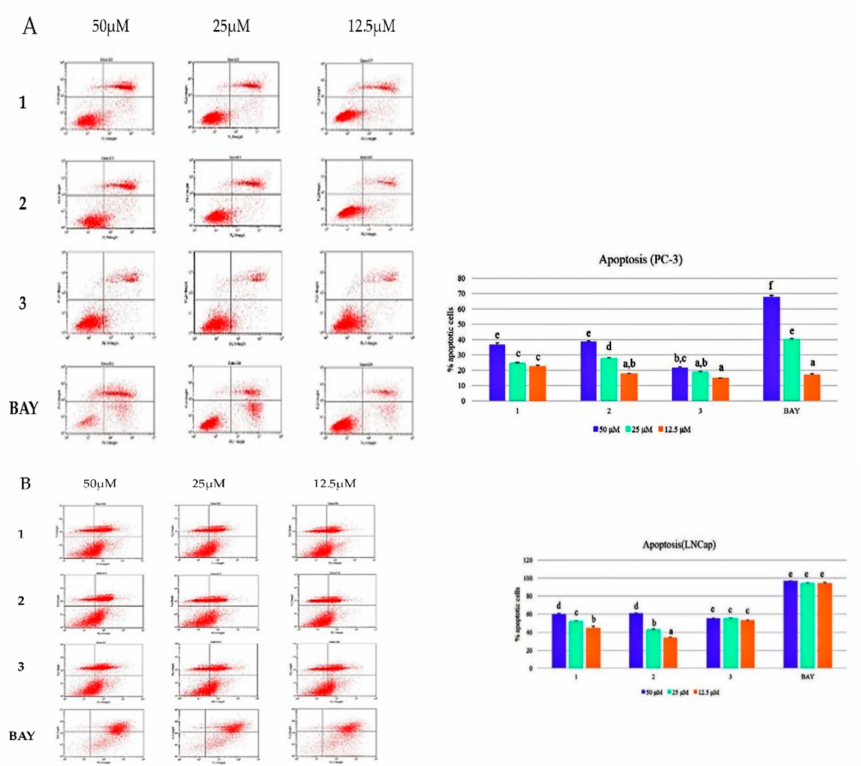
Figure 3. Apoptosis-inducing activities of various concentrations of oregonin ( 1 ), hirsutenone ( 2 ), and hirsutanonol ( 3 ) in PCa cell line. ( A ): PC-3 cells; ( B ): LNCaP cell. The results are expressed as mean ± SD of triplicate experiments ( n = 3). BAY : positive control. Letters a–o in the same column indicate significant differences, p <